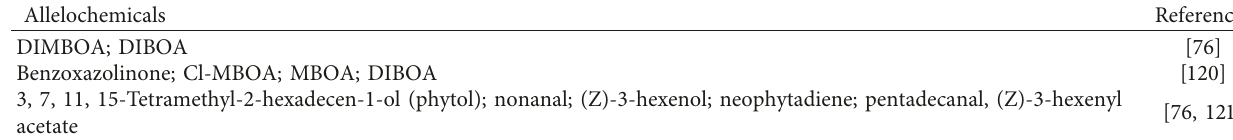
Table 3: Allelochemicals reported in the corn crop.